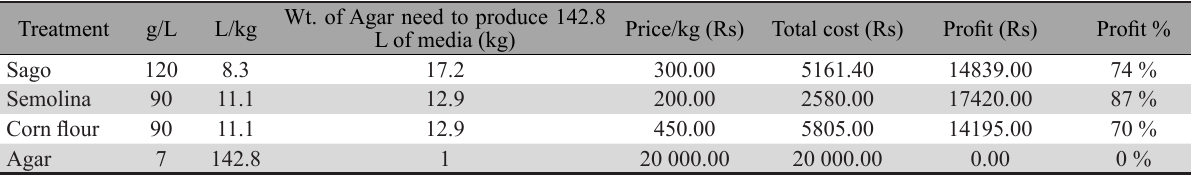
Table 5. Cost reduction in MS media for different gelling agent Treatment